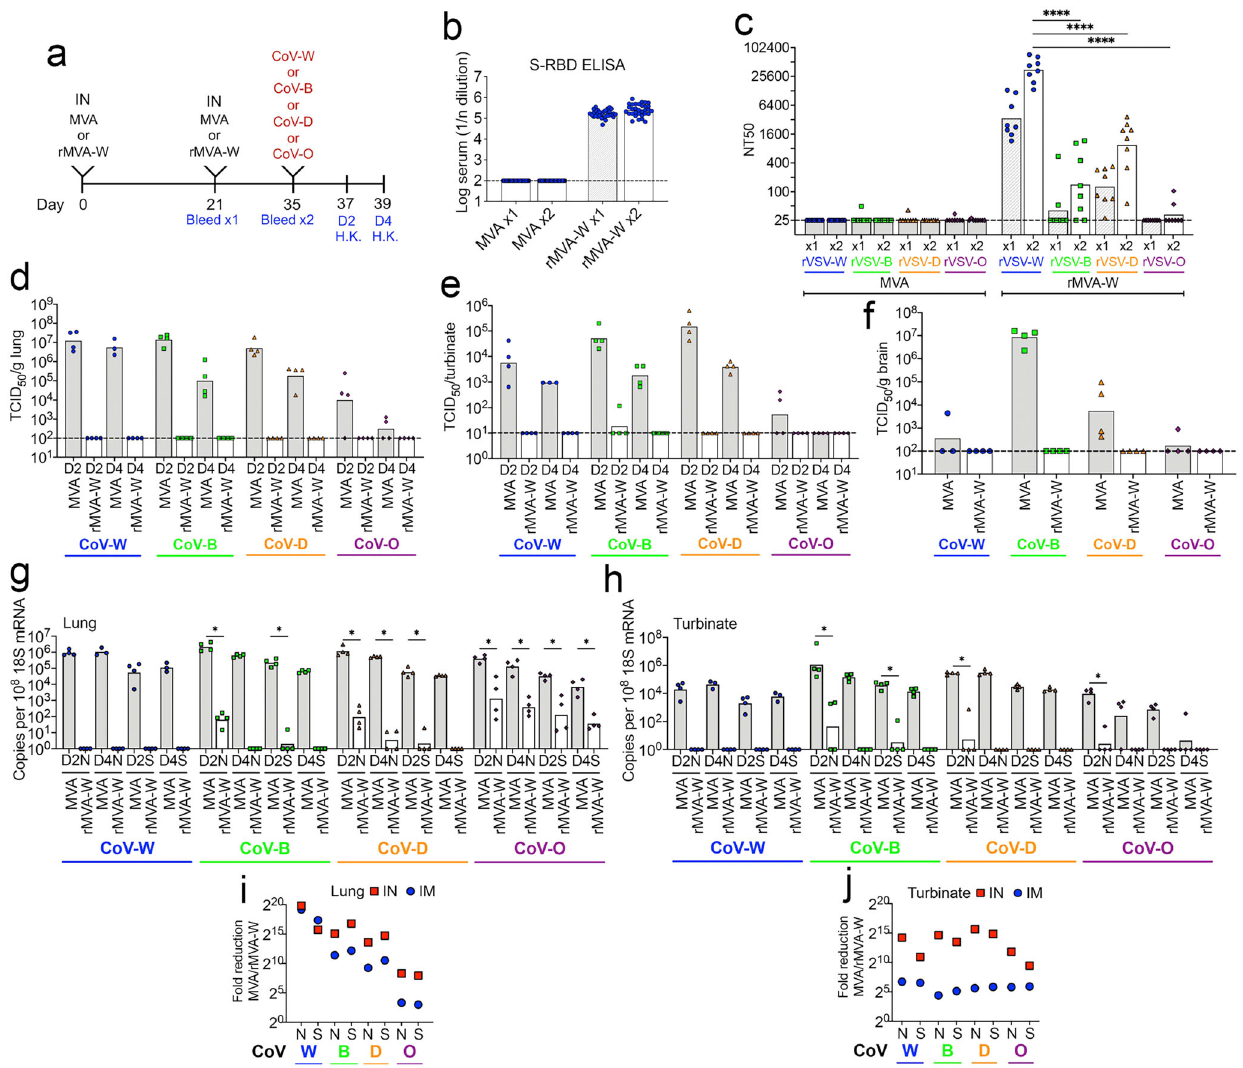
Fig. 4 Inhibition of variant SARS-CoV-2 infections in mice immunized IN with rMVA-W. a Timeline of K18-hACE2 mice vaccinated IN twice with 2 × 10 7 PFU of MVA control ( n = 31) or rMVA-W ( n = 32), divided into groups of 7 or 8 and 2 weeks later challenged with 10 4 TCID 50 of CoV-W, -B, or -D or 5 × 10 4 TCID 50 of CoV-O. Half the mice were H.K. on day 2 and remainder on day 4. b Serum antibody binding to Wuhan RBD determined by ELISA after the fi rst and second immunizations. ( n = MVA 31, rMVA 32). c Neutralization of pseudoviruses rVSV-W, -B, -D and -O by serum obtained after the fi rst and second immunizations. ( n = 8 per group). Recovery of SARS-CoV-2 from d lungs and e nasal turbinates on days 2 and 4 and f brain on day 4 after challenge. n = 3 or 4 per group. Copies of sgRNAs N and S relative to 18 S RNA from g lungs and h nasal turbinates on days 2 and 4 after challenge. Fold-reduction of sgRNAs in nasal turbinates on day 2 for mice immunized i IN and j IM. Data replotted from Figs. 3g and 4h. Statistics: for c ANOVA with Tukey post-hoc; for g , h Mann-Whitney. * p ≤ 0.03; ** p ≤ 0.002; **** p < 0.0001. Dotted line, limit of